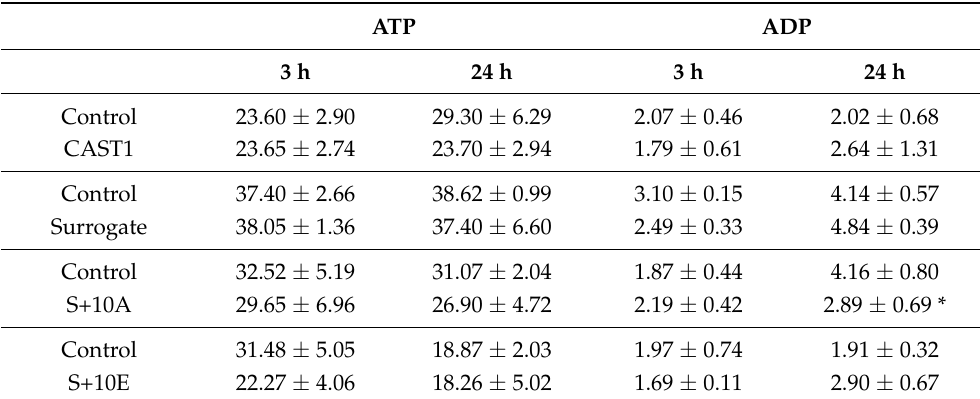
Table 3. ATP and ADP levels (nmol/mg protein) in BEAS-2B cells after 3 h or 24 h of exposure to particles or to air (control). Data are expressed as mean ± SD, n = 4–5 independent experiments. * p < 0.05 vs.